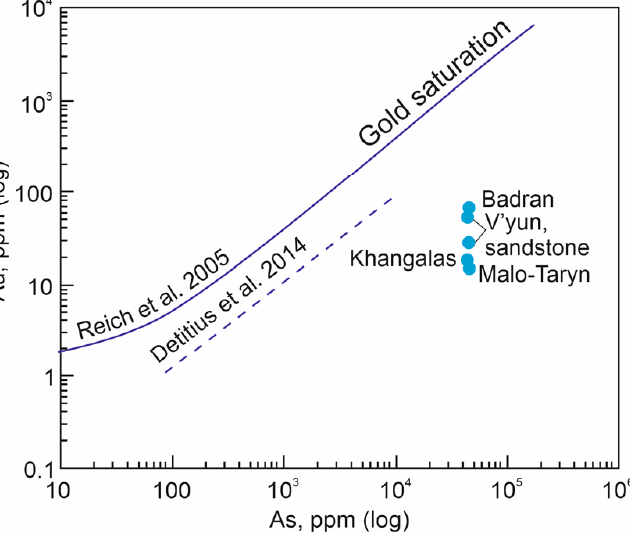
Figure 23. Au ‐ As plot for mean values of Apy1 in the studied OGDs, central YKMB. The lines of gold saturation after [32,49].